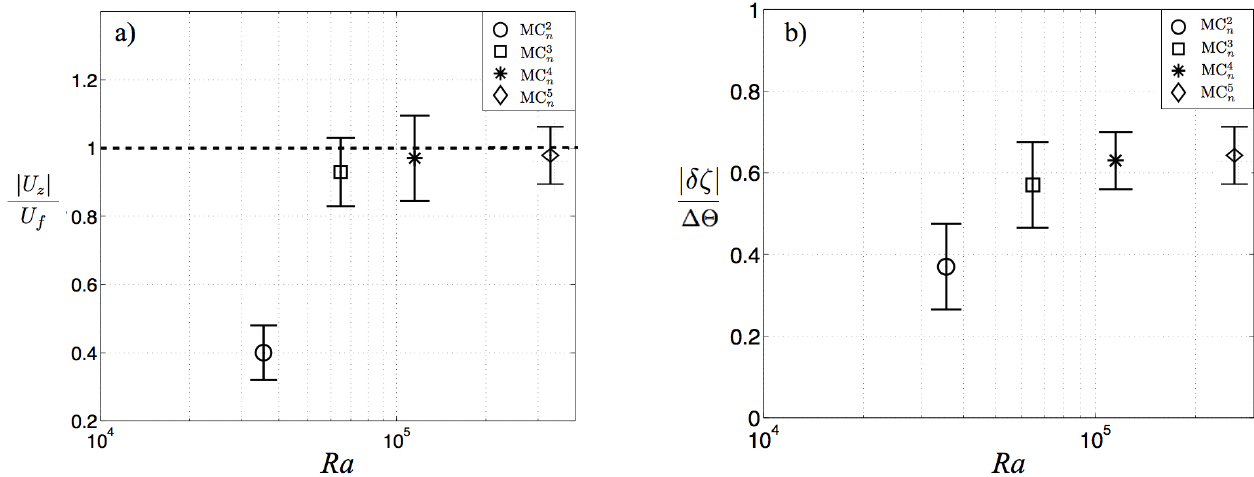
Figure 12. SFEMaNS-T MC simulation results. ( a ) Maximum, time-averaged, mid-plane vertical flow velocity normalized by the free-fall velocity U mid-plane temperature anomalies normalized by the vertical temperature gradient ∆Θ